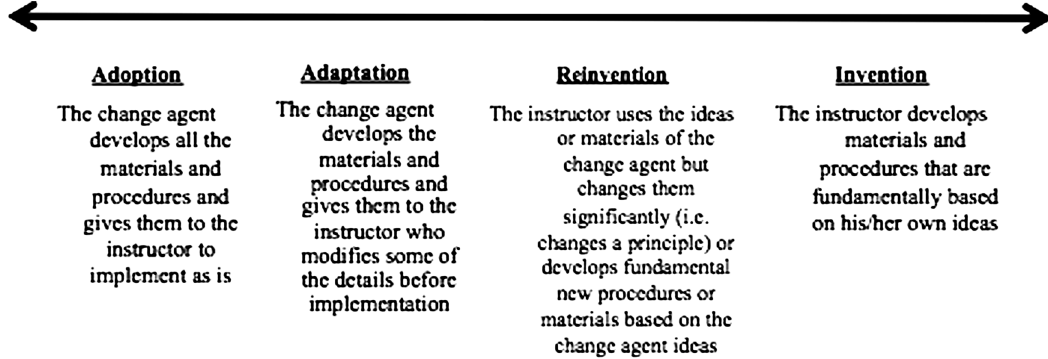
FIG. 1. Adoption-invention continuum (Ref.